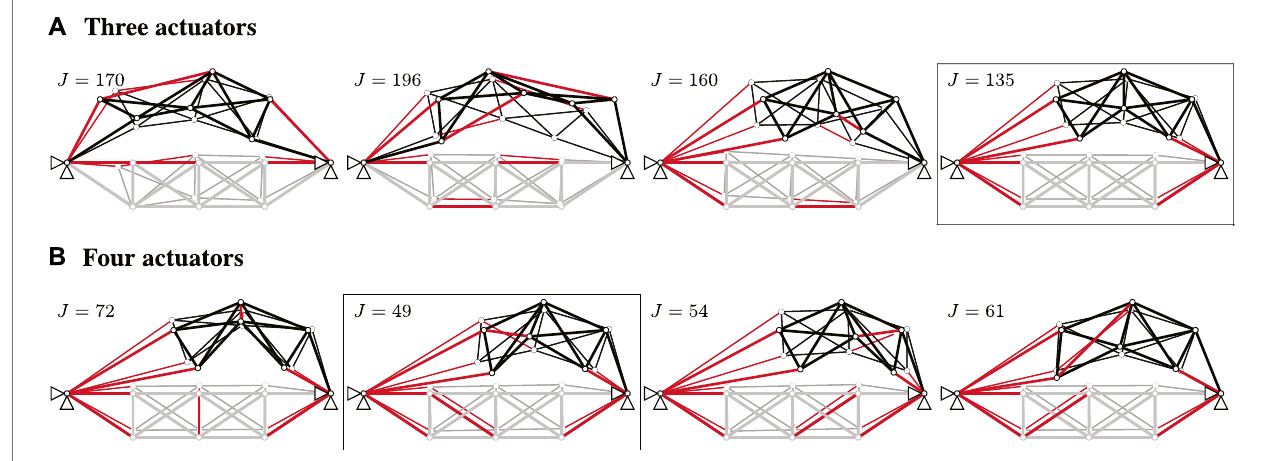
FIGURE 8 | Actuator placement for elastic energy minimization. (A) Three actuators. (B) Four actuators.